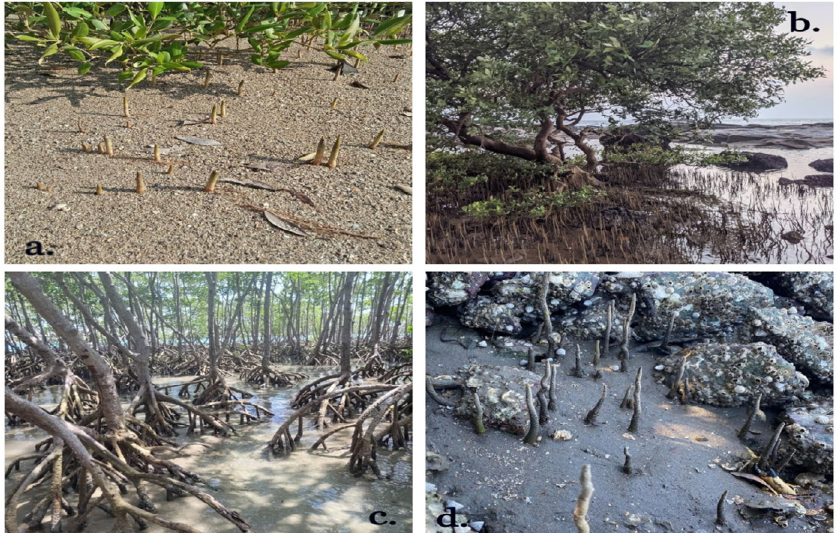
Fig. 1. Collection of soil samples from different locations of mangroves a) Gorai Beach, b) Godrej Mangroves, and c) and d) Vikhroli